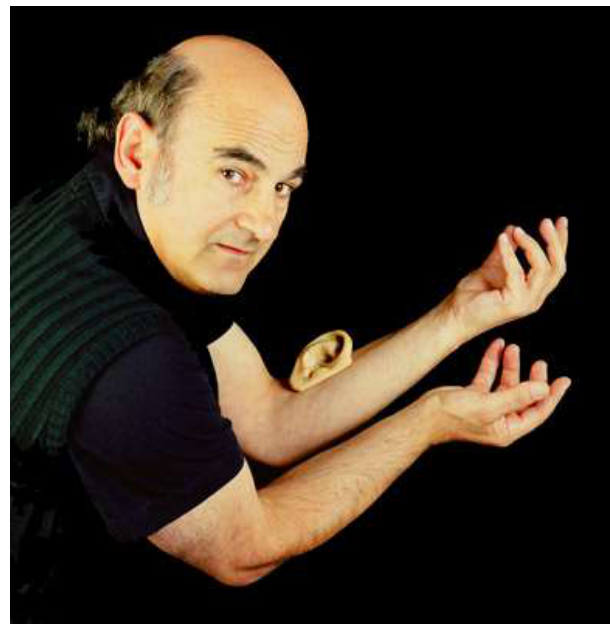
Figure 3. Stelarc implanted a third